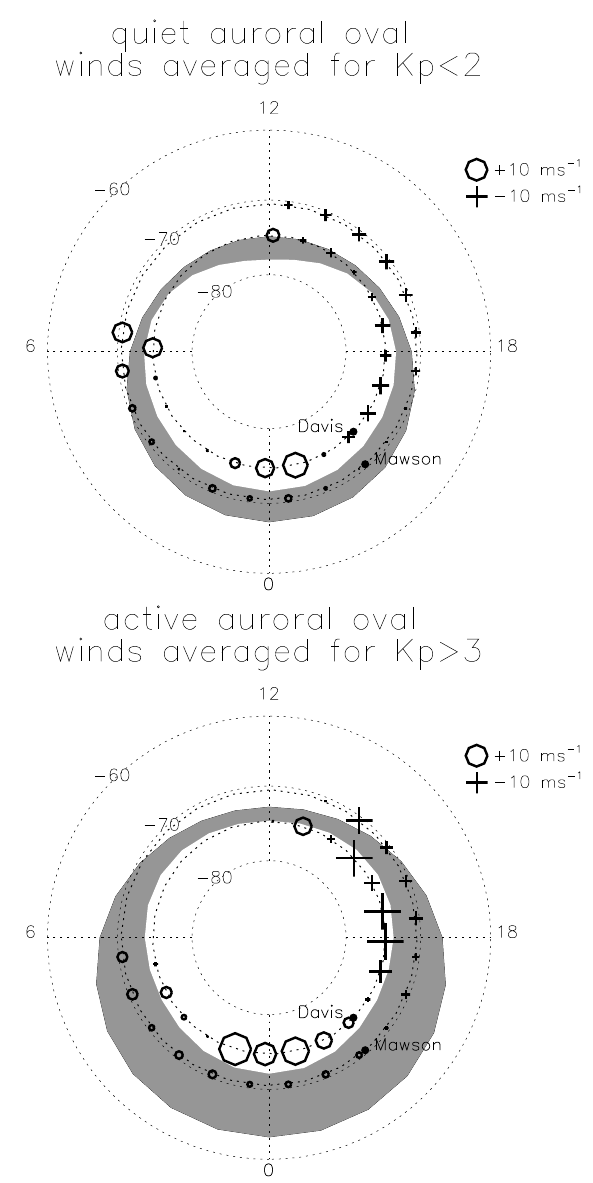
Fig. 7. Hourly mean vertical winds from Davis and Mawson with respect to the auroral oval at geomagnetically quiet (top) and ac- tive (bottom) conditions, based on a model by Holzworth and Meng (1975). For the quiet auroral oval, winds from intervals when K p < 2 were averaged and for the active auroral oval, winds from intervals when K p > 3 were averaged. A wind scale is indicated on the right; local magnetic time on the perimeter of the map; and local midnight by filled circles labelled with station